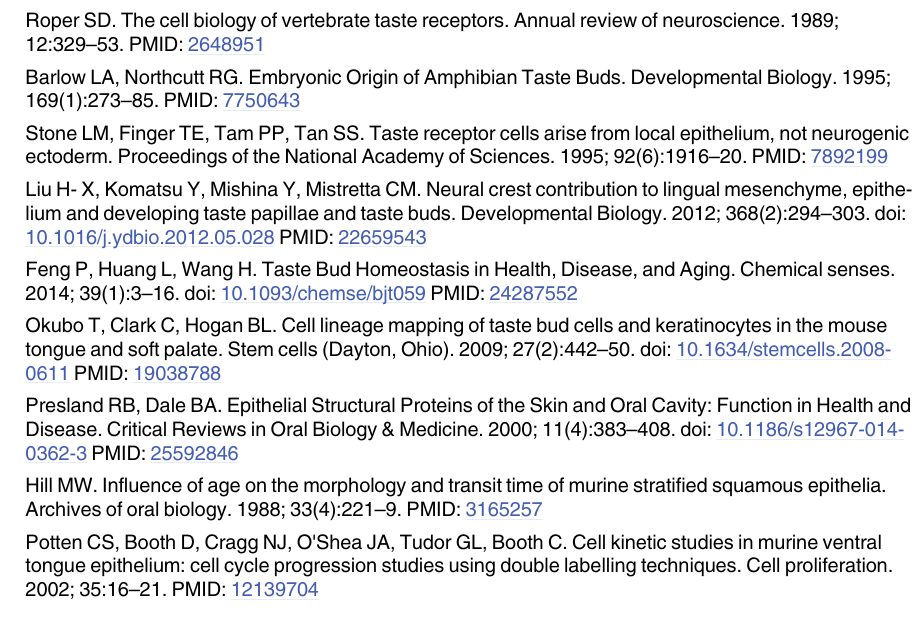
S1 Table. The number of lineage-labeled Type II and III cells in taste buds in the FFP and CVP does not differ between control (ShhCreERT2;R26R-YFP) and mutant (ShhCreERT2;